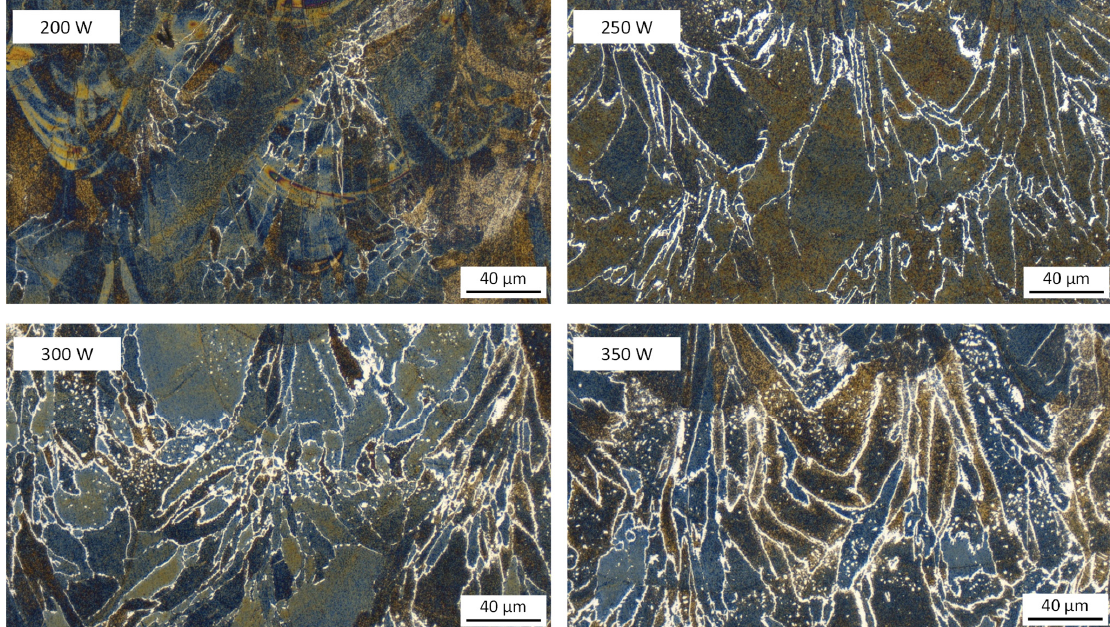
Figure 12. Influence of laser energy input on the microstructure of the monolithic duplex stainless steel X2CrNiMoN25 ‐ 7 ‐ 4 (laser power 200–350 W, laser scan speed 800 mm/s), examined by using light optical microscopy. Building direction is upward for all images.